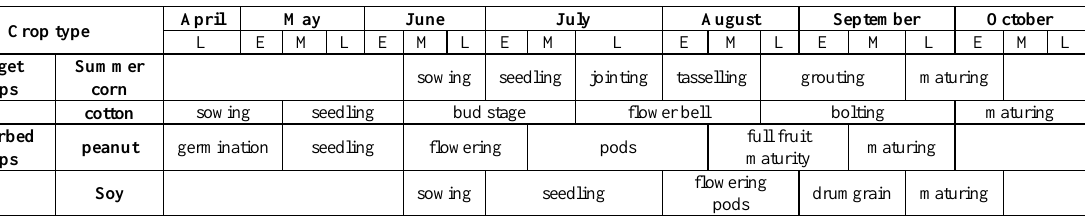
Table 3.The phenological table of autumn crops in Jingxian